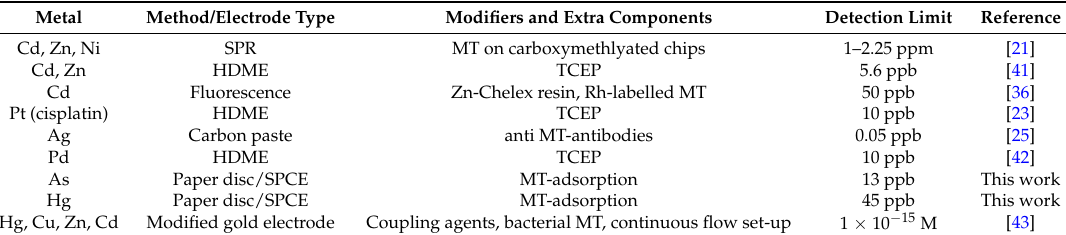
Table 2. Summary of MT-incorporated